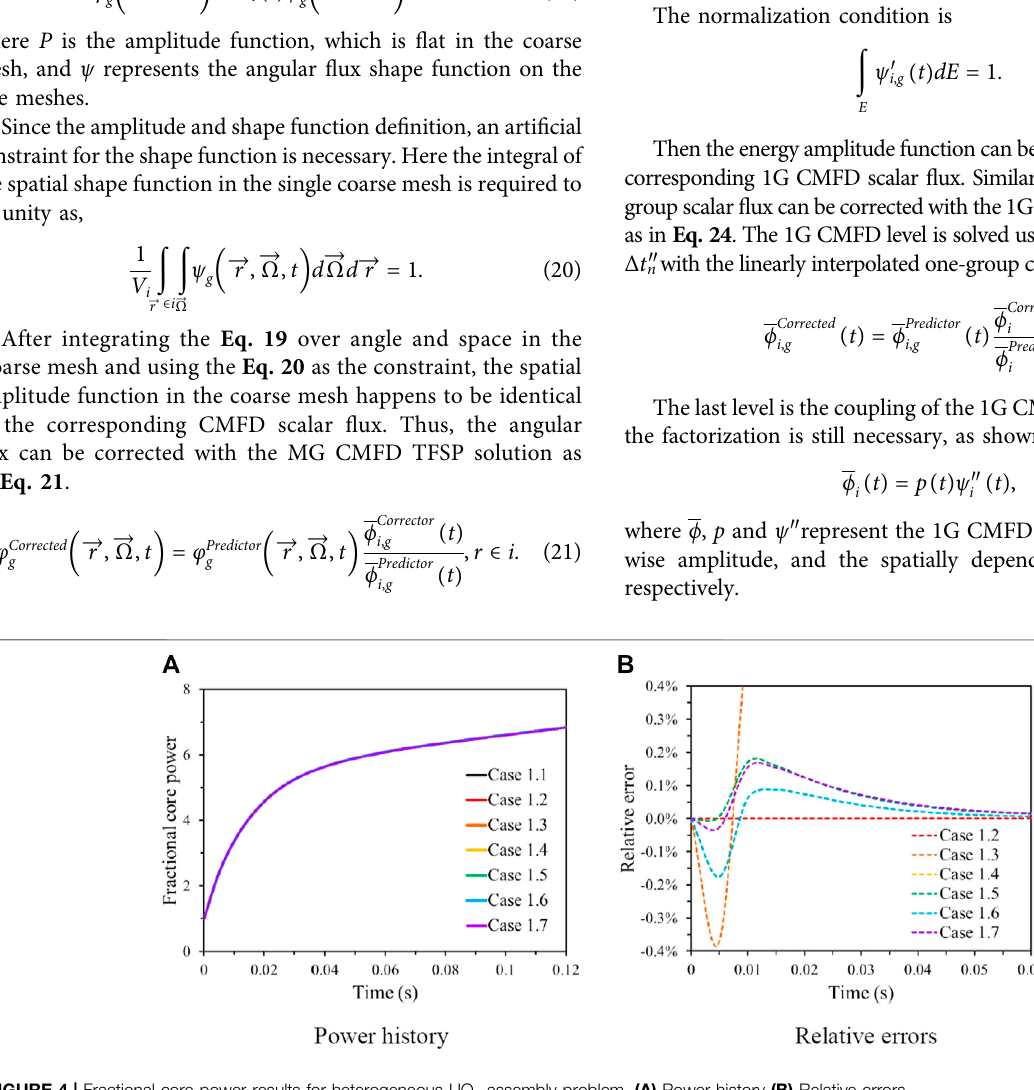
Frontiers in Energy Research |